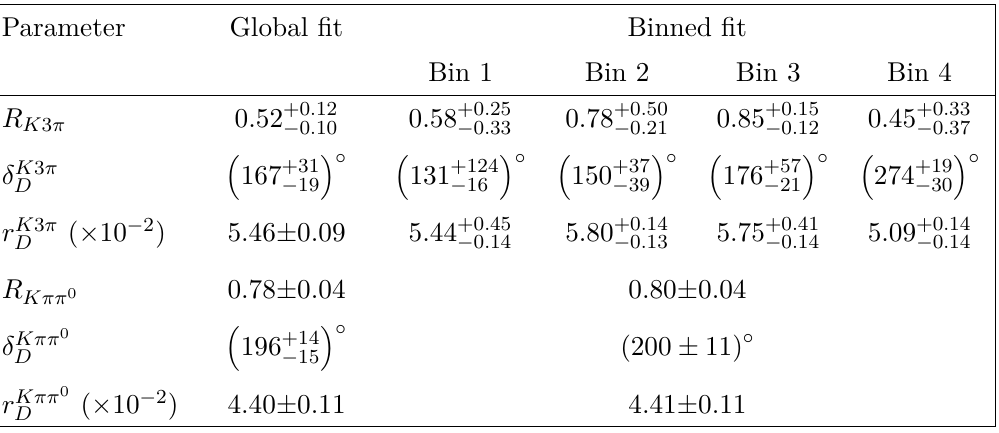
Table 11 . Fitted central values for the hadronic parameters, from the global and binned analyses. The uncertainties include both statistical and systematic contributions.